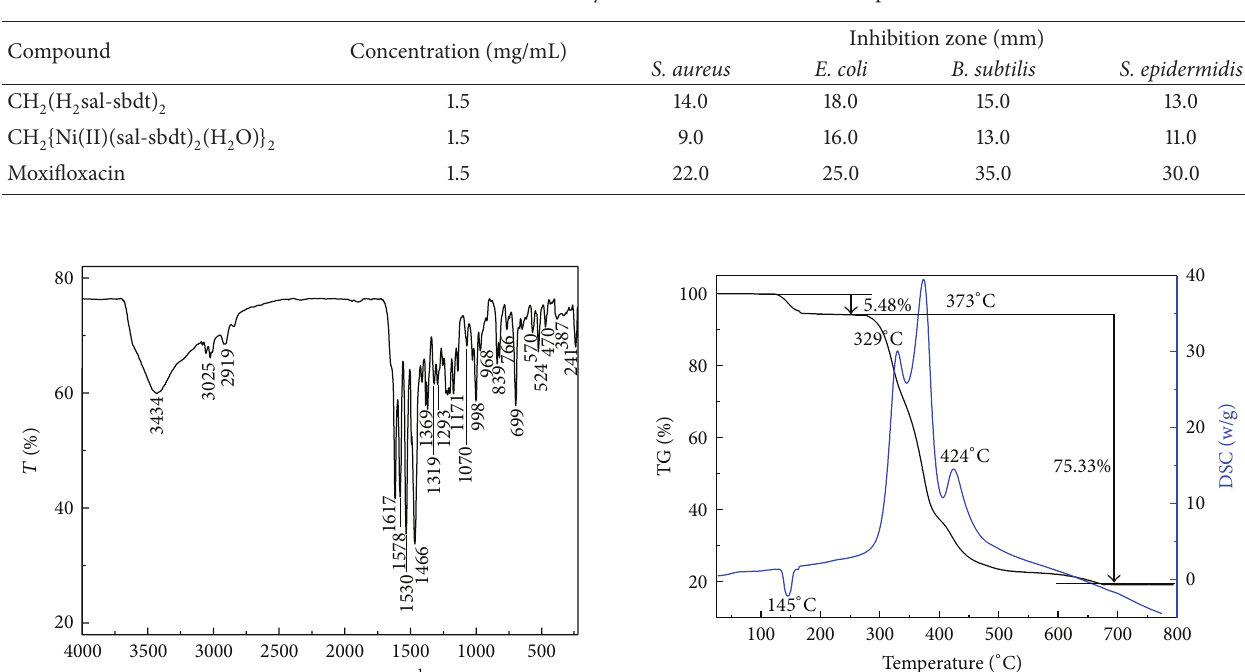
Table 3: Antibacterial activity of the Schiff base and the complex.